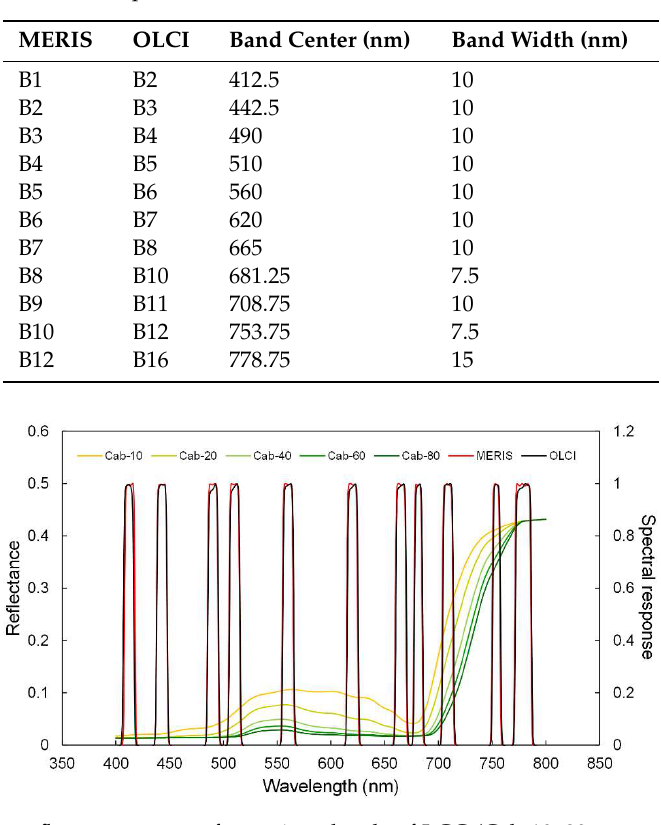
Figure 3. Canopy reflectance spectra for various levels of LCC (Cab 10–80 µ g cm − 2 ) together with MERIS (bands 1–10 and 12) and OLCI (bands 2–8, 10–12 and 16) spectral response